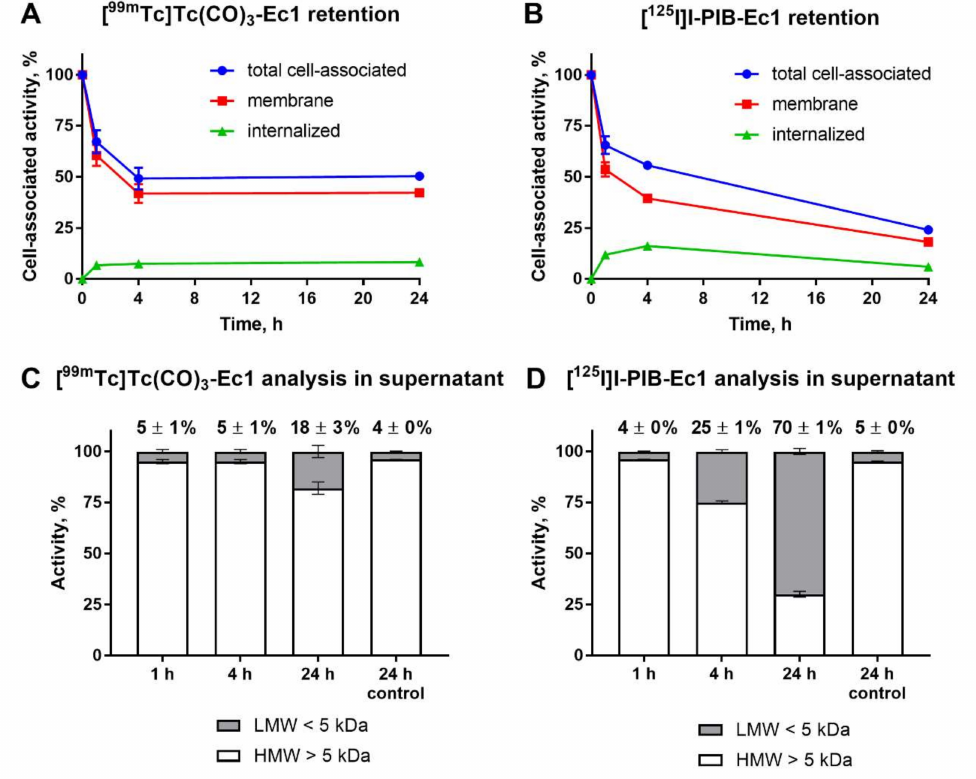
Figure 4. Cellular retention of activity after interrupted incubation of [ 99m Tc]Tc(CO) 3 -Ec1 ( A ) and [ 125 I]I-PIB-Ec1 ( B ) with MDA-MB-468 cells. Cells were first incubated with the DARPin variants (10 nM) at 4 ◦ C for 1 h and then the media were exchanged and the cells were incubated at 37 ◦ C for 1, 4, or 24 h. A fraction of the supernatant at every time point was analyzed using NAP-5 size-exclusion columns and compared to the control when the radiolabeled DARPins were incubated in complete media for 24 h ( C , D ). Numbers in panels ( C , D ) show a percentage of activity associated with low-molecular-weight compounds at each time point. Data for retention are presented as the mean of three samples ± SD and data for NAP-5 analysis are presented as the mean of two samples ± SD. LMW = low molecular weight, HMW = high molecular weight. Error bars might not be seen when they are smaller than data point